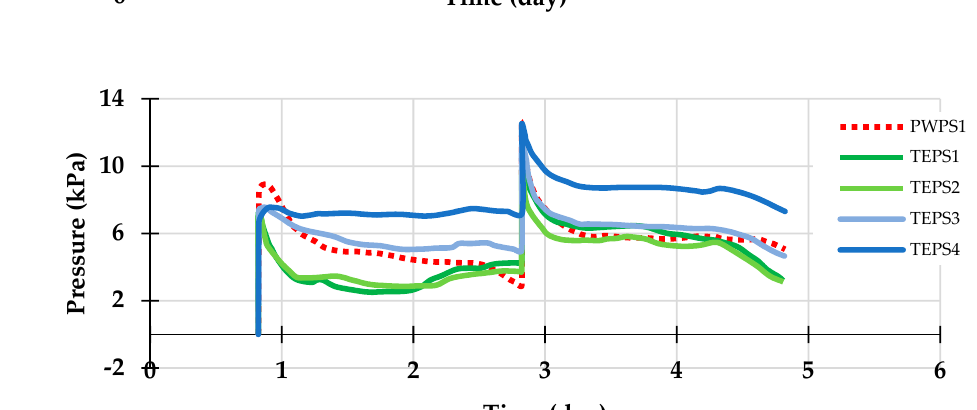
Figure 7. The measurement of the backfill pressure at the base of the stope: ( a ) for the GSD #1 barricade, and ( b ) for the GSD #5 barricade.